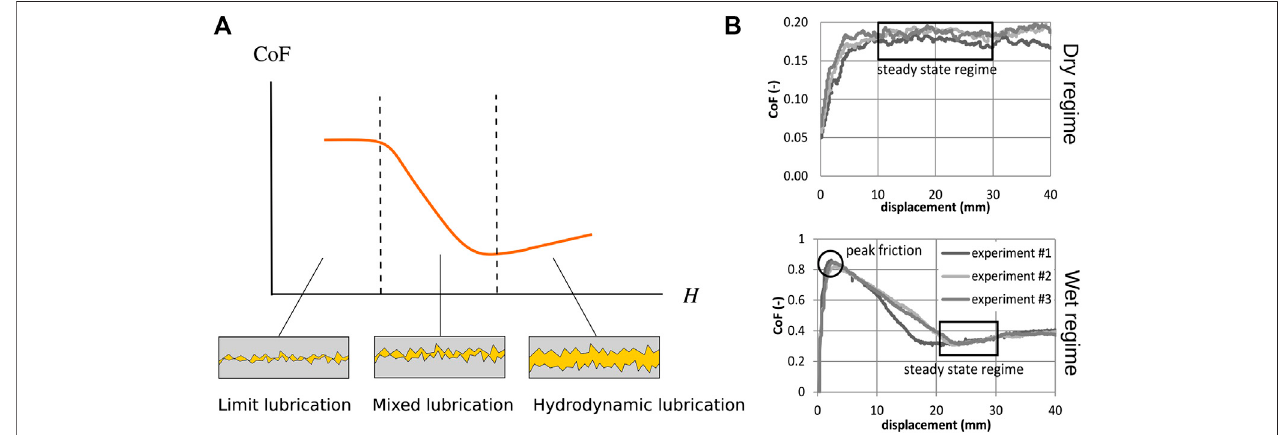
FIGURE6|(A) Stribeckcurveandschematicillustrationofthedifferentlubricationregimesand (B) examplesofdry (top) andwet (bottom) frictionforTwintex ® PP from Sachs et al. (2012).